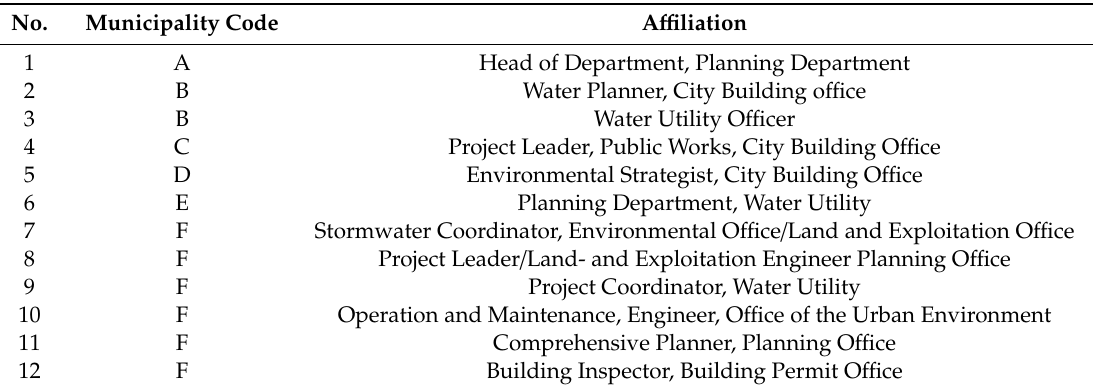
Table 2. Individual Interviews carried out for the